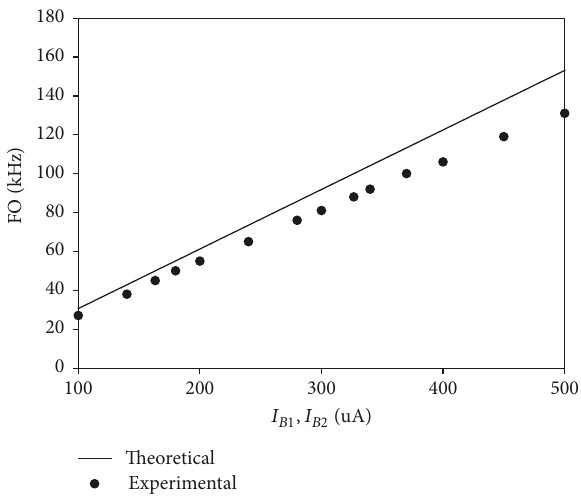
Figure 9: Tuning of experimental and theoretical FO by adjusting bias current.